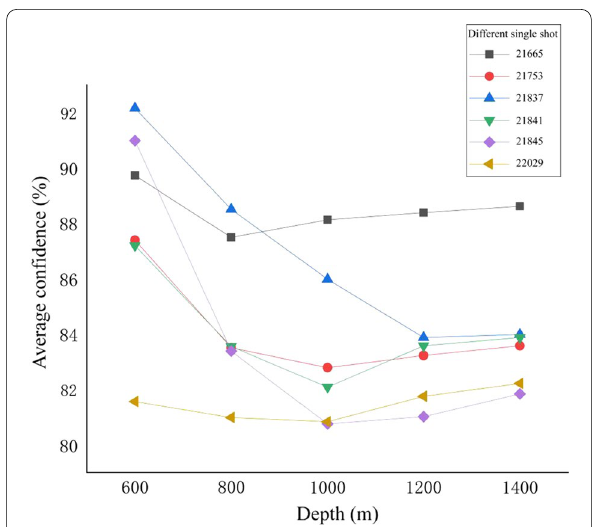
Fig. 7 Average confidence of different depths (21665, 21753, 21837, 21841, 21845, 22029 indicate different points in the profile)